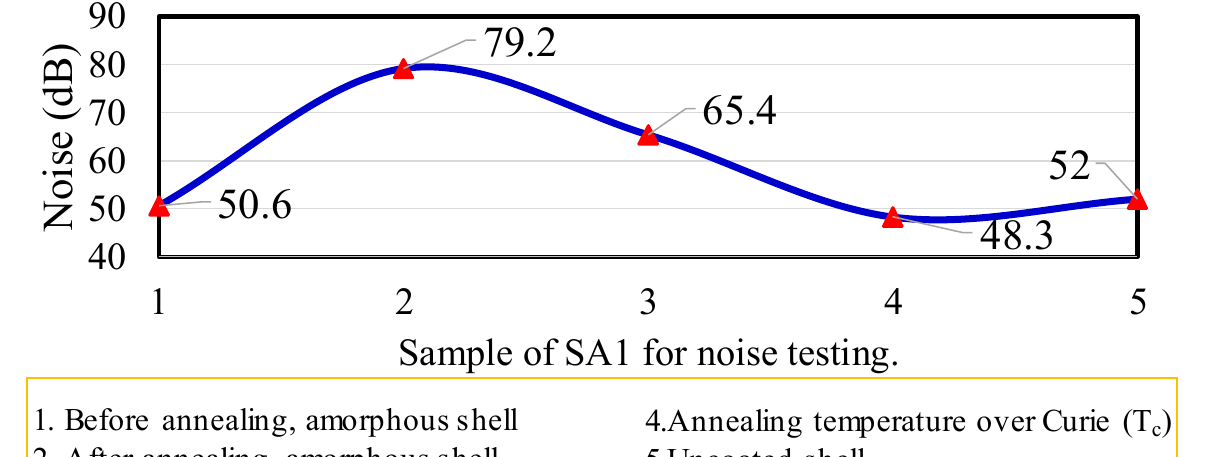
Figure 11. Measured generator noise with different annealing treatments of the amorphous shell.